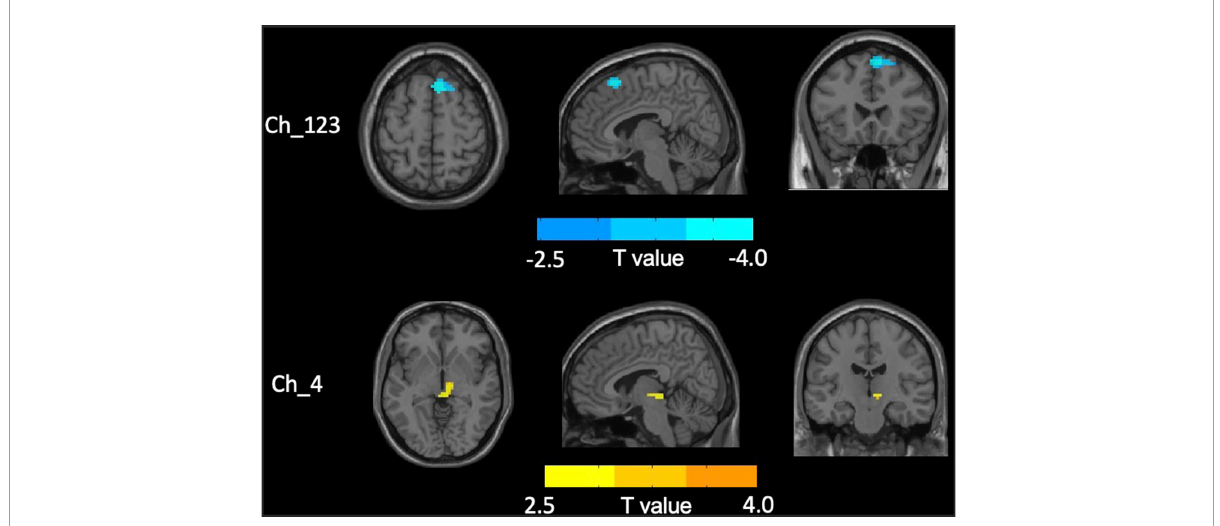
FIGURE3 Distinct functional connectivity (FC) alterations of basal forebrain (BF) subregions in insomnia disorder (ID) compared to healthy control (HC). The figure represents decreased FC between medial superior frontal gyrus and Ch_123 as well as increased Ch4-midbrain FC in ID group compared to HC. The color bar represents the height of suprathreshold t -values.